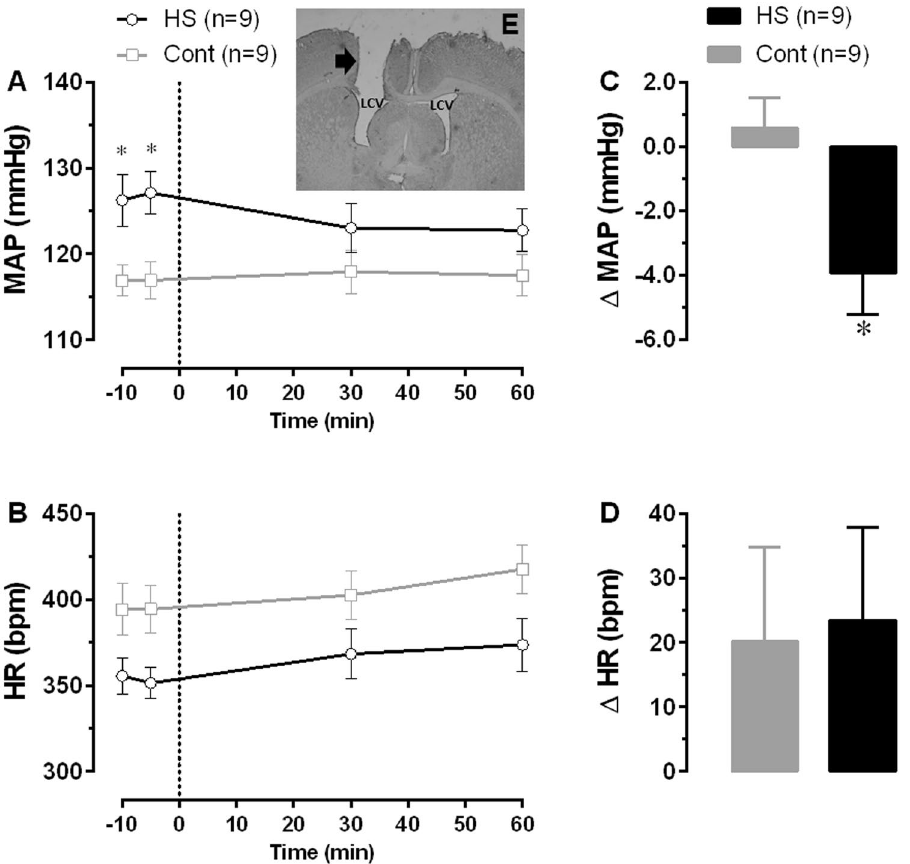
Figure 4. Cardiovascular effects of central losartan microinjection into the lateral cerebral ventricle (LCV). Direct measurements of blood pressure were performed on the 12 th week after weaning in rats from HS and respective control groups. Vertical dashed line mark the losartan microinjection (180 nmol/kg) event. Panels A and B represent absolute levels of MAP and HR over time and panels C and D represent change of MAP and HR 60 minutes after injection. Panel E shows a coronal brain slice at the lateral cerebral ventricle (LCV) level with the guide cannula tract (black arrow) indicating microinjection into the LCV. * Different of Cont group; two- way ANOVA for repeated measurements followed by Bonferroni’s post-test; p <